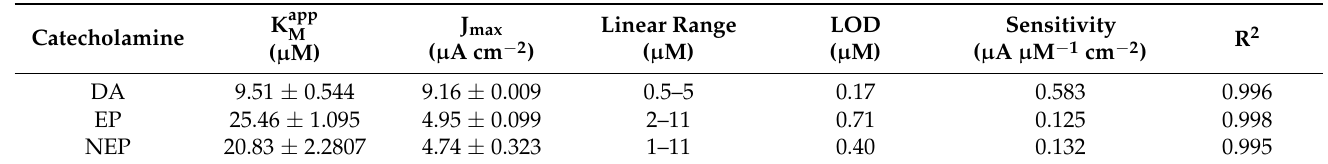
Figure 7. Calibration curves of Tyr/EDC-NHS/ChitNPs/GPH/SPE as a function of the concentration of catecholamine: DA (black curve), EP (blue curve), and NEP (green curve). Inset: the magnification of the linear range. Table 2. Comparison of the kinetic and analytical characteristics of Tyr/EDC-NHS/ChitNPs/GPH/ SPE biosensors with different